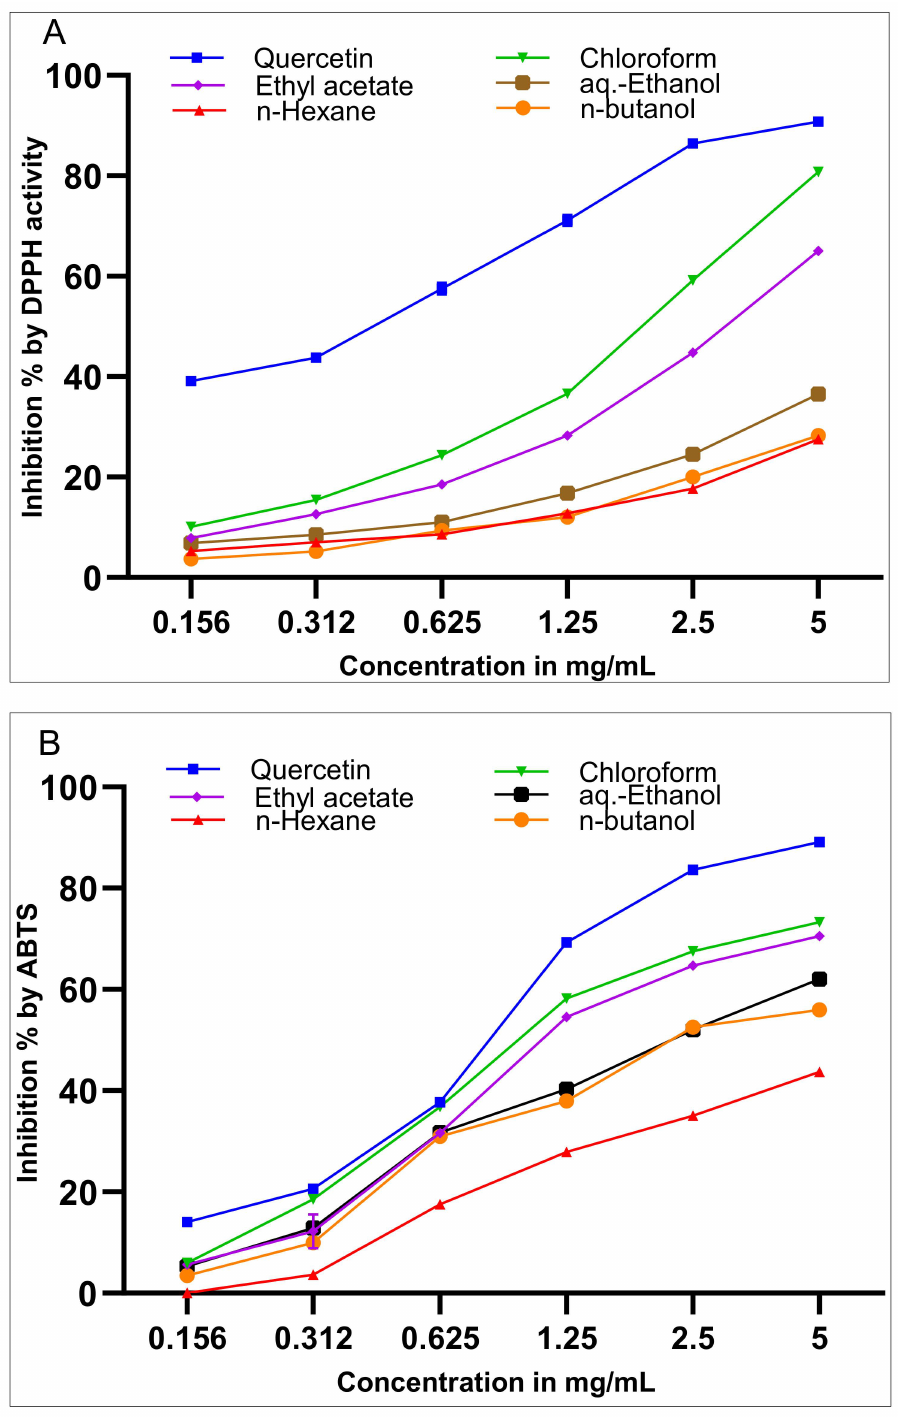
Figure 1. Radical scavenging activity of Suaeda vermiculata extracts by ( A ) 1,1-diphenyl-2-picrylhydrazyl (DPPH), and ( B ) 2,2’-azino-bis-3-ethylbenzthiazoline-6-sulphonic acid (ABTS) methods. Values are the mean of three replicates ± SEM. p < 0.0001 using two-way ANOVA, and p < 0.0001 compared to quercetin for all groups at all the measured concentrations for both methods according to multiple comparisons for Tukey’s